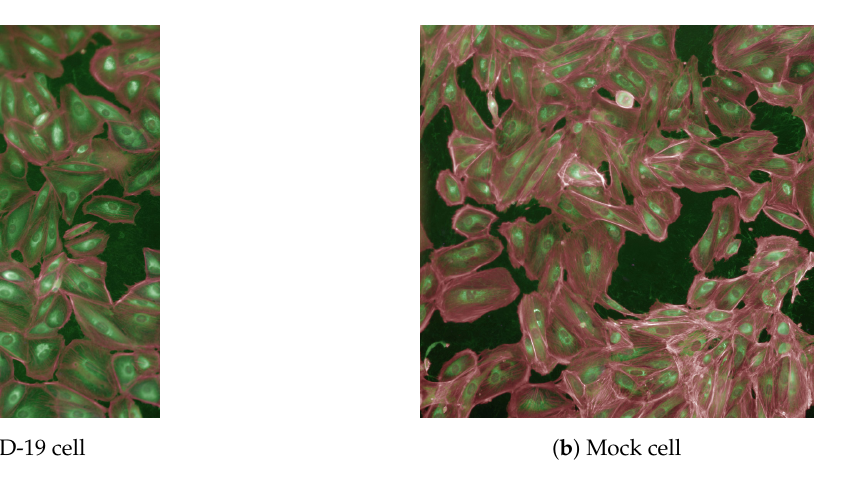
Figure 1. An active-viral cell image and a mock cell